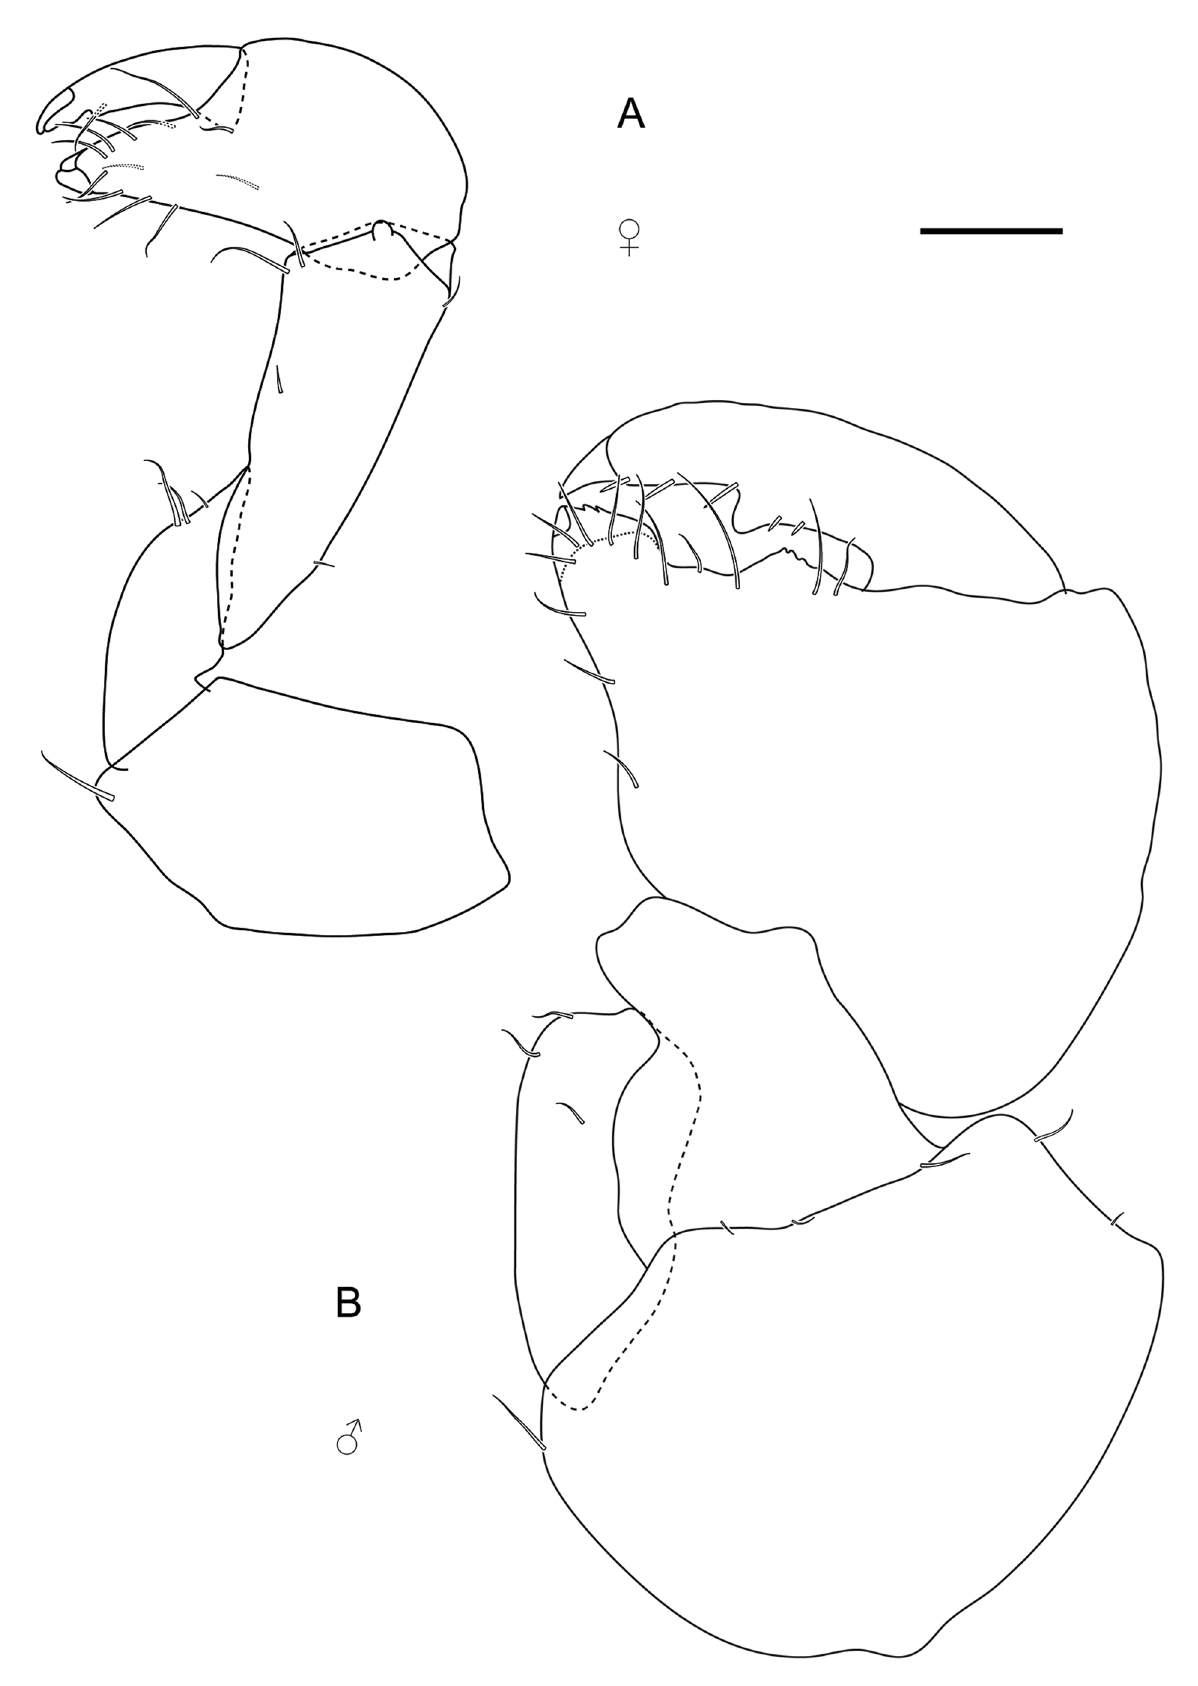
Figure 5. Apseudomorpha brasiliensis sp. nov. Paratype, ovigerous female (MNRJ 29857) and male (MNRJ 29858) dissected. A Cheliped female; B cheliped male. Scale bar: 0.1